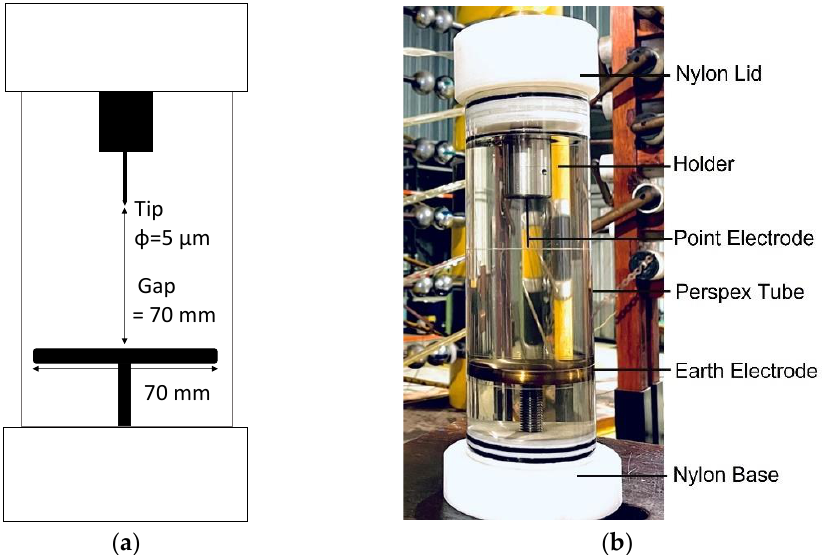
Figure 1. The Perspex test cell: ( a ) The electrode configuration is point-plane. The point electrode is 50 mm long, with a tungsten tip of radius r = 5 ± 1 μm. The plane electrode is made of brass with a diameter of 70 mm and is earthed. The gap size is 70 mm.; ( b ) Image of test cell with annotations.